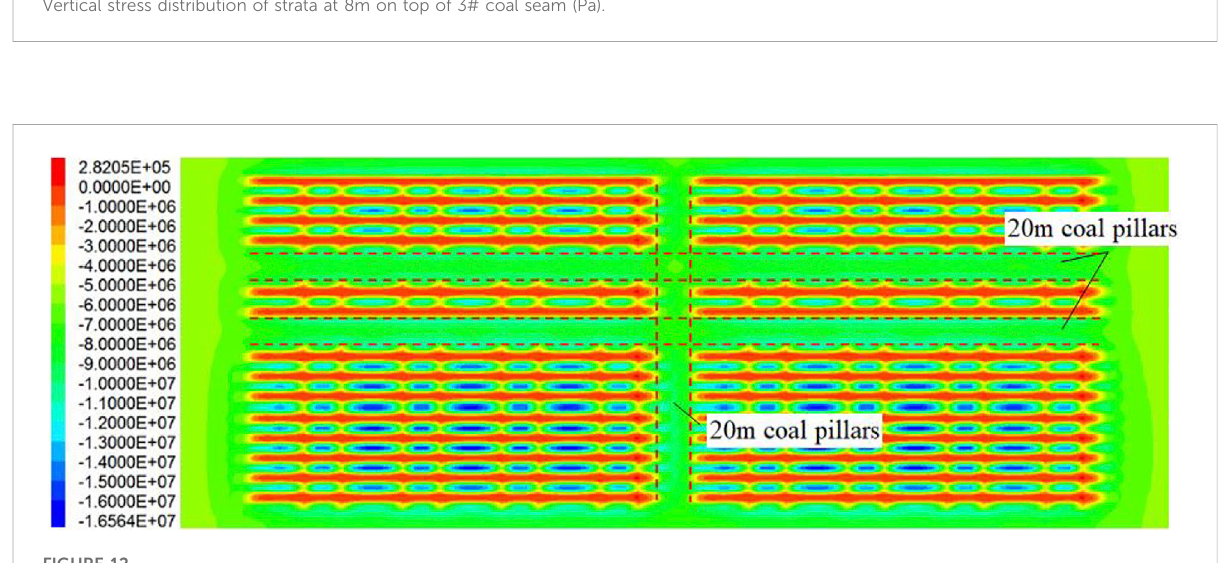
FIGURE 12 Vertical stress distribution of strata at 10m on top of 3# coal seam (Pa).